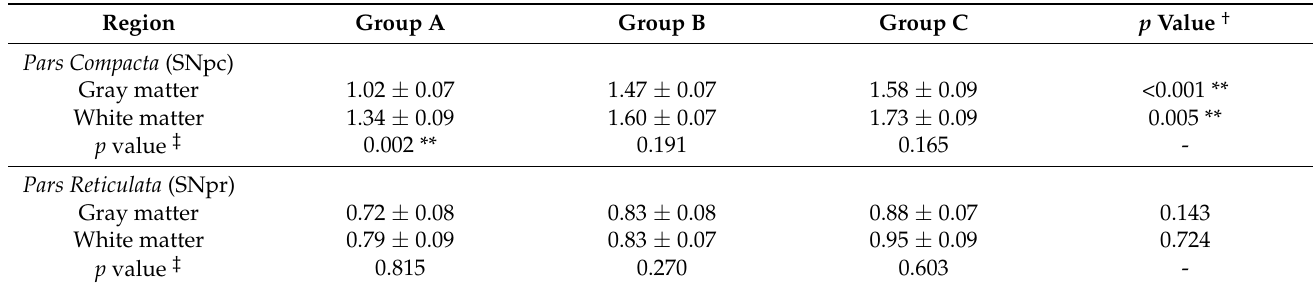
Table 6. Distribution of CD11b+ cells per visual field in different regions of Substantia Nigra